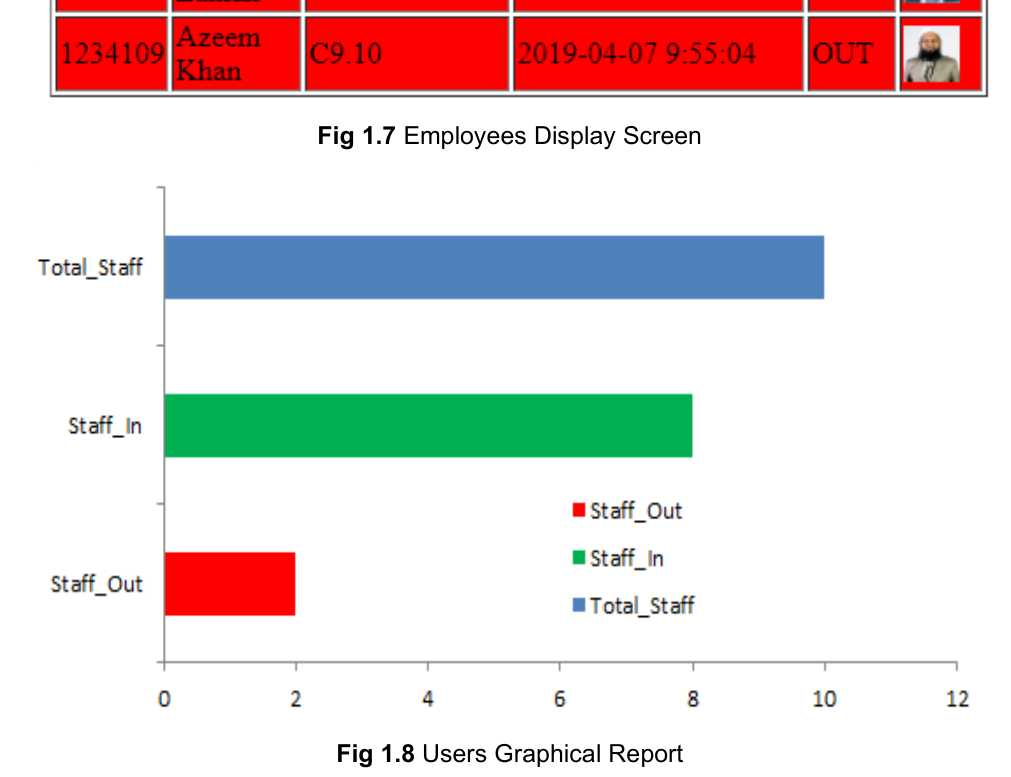
Fig 1.8 Users Graphical